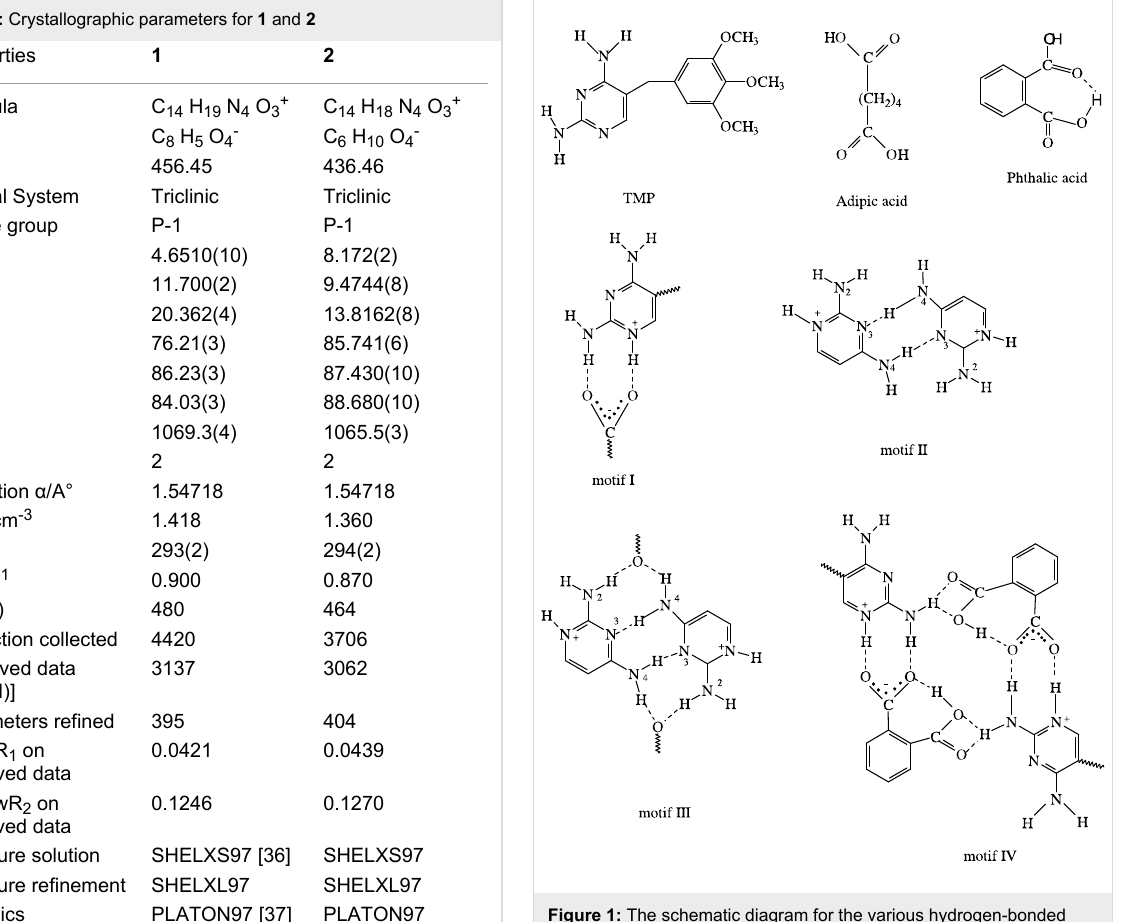
Figure 1: The schematic diagram for the various hydrogen-bonded motifs observed in compound ( 1 ).